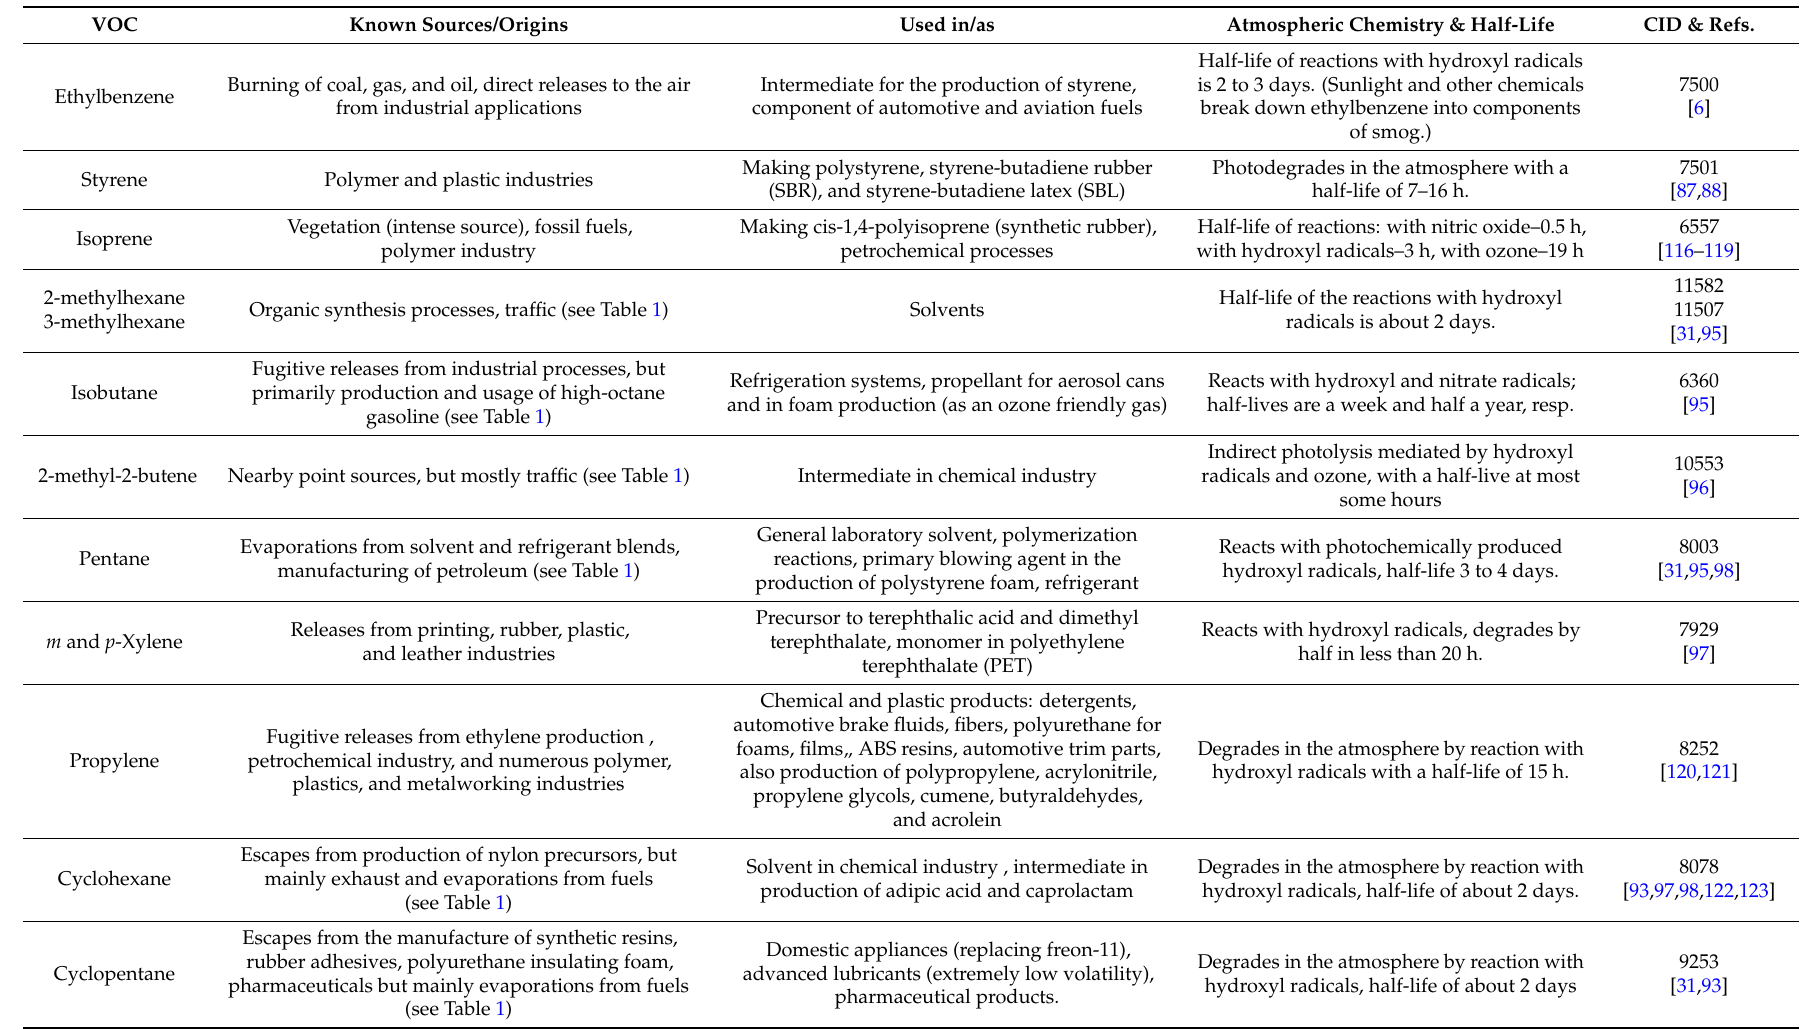
Table 5. VOCs profiling the polymer, plastics, and metalworking